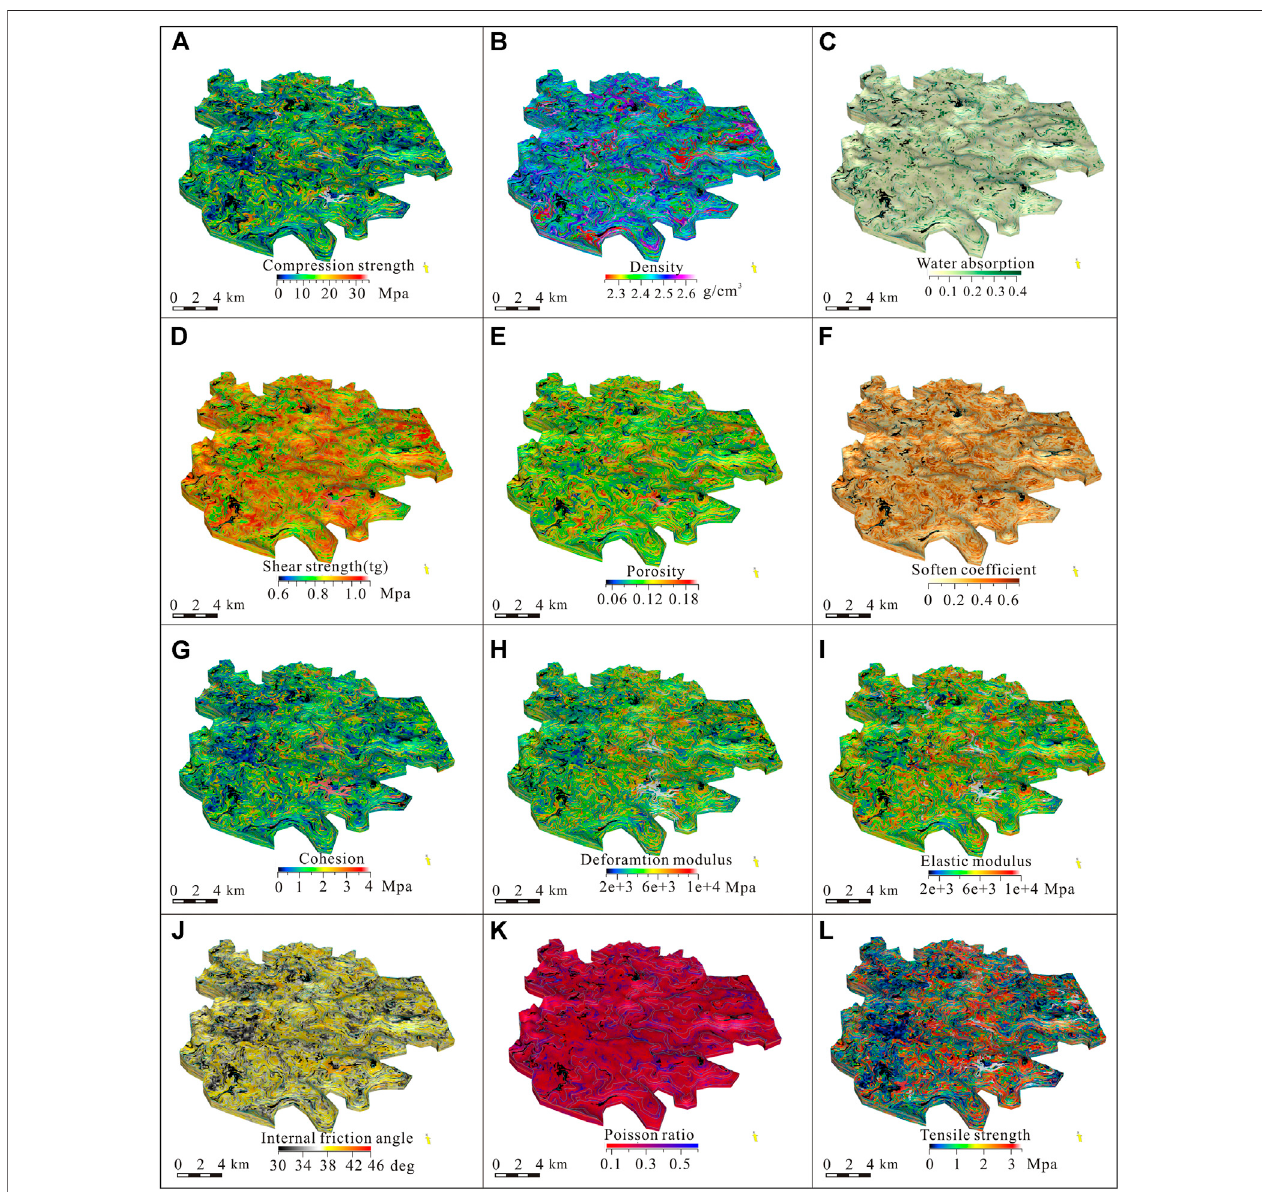
FIGURE 8 | Geotechnical attribute model of Guang ’ an city. (A) compression strength; (B) density; (C) water absorption; (D) shear strength (tg); (E) porosity; (F) soften coef fi cient; (G) cohesion; (H) deformation modulus; (I) elastic modulus; (J) internal friction angle; (K) Poisson ’ s ratio; (L) tensile strength.